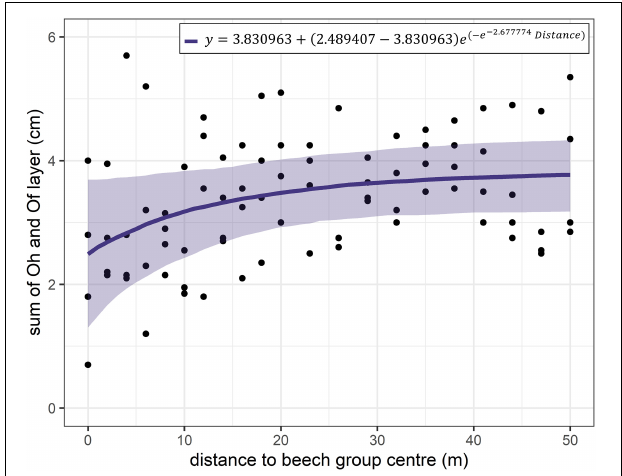
FIGURE 5 | Result of the non-linear model for modelling the sum of Oh and Of horizon thickness as a function of the distance to the centre of the beech group. The transparent polygons show the 95 % confidence